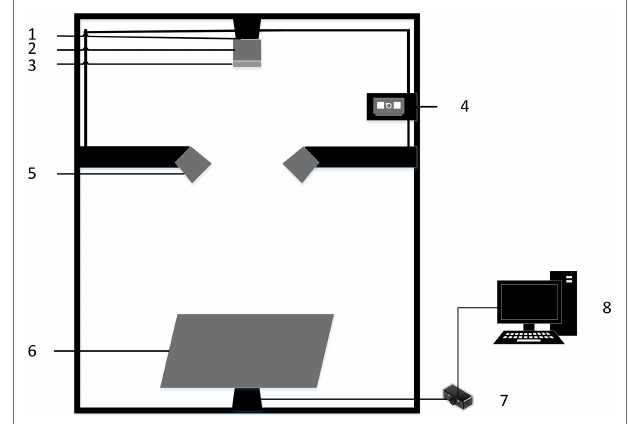
FIGURE 2 | Hyperspectral imaging system: (1) CCD camera; (2) Hyperspectral imaging spectrometer; (3) Lens; (4) Light source controller; (5) Light source; (6) Displacement stage; (7) Displacement stage controller; and (8)